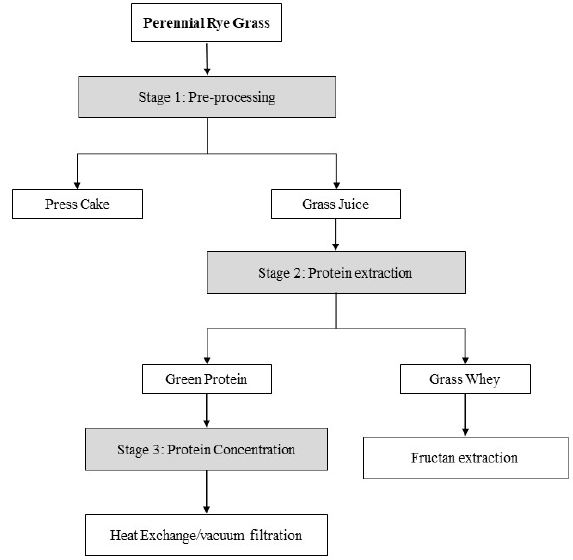
Figure 1. Schematic of protein extraction from perennial rye grass.